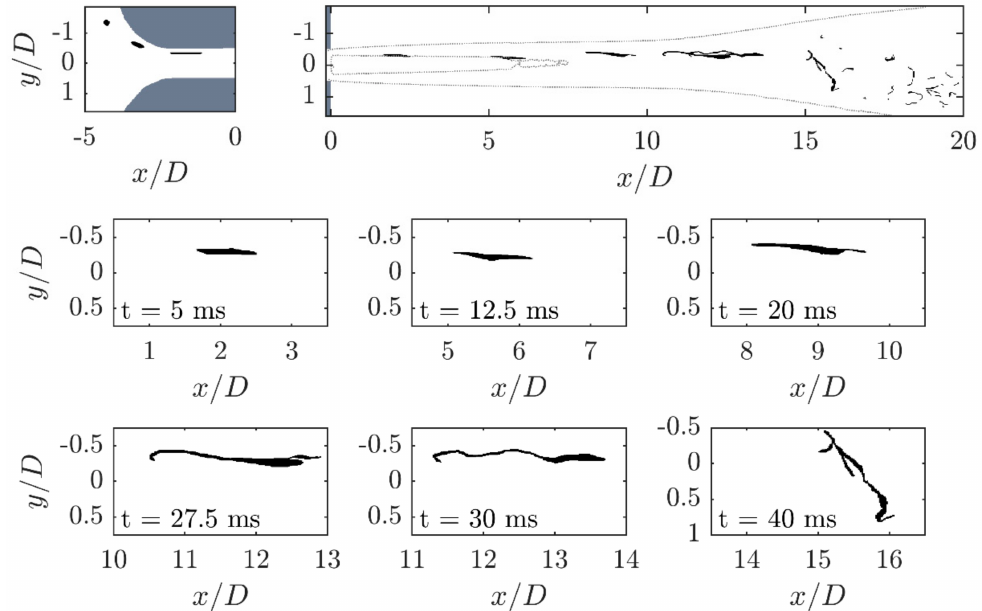
Figure 8. Evolution of a droplet passing through the orifice at the edge of the jet core (r ∗ = 0.8 )